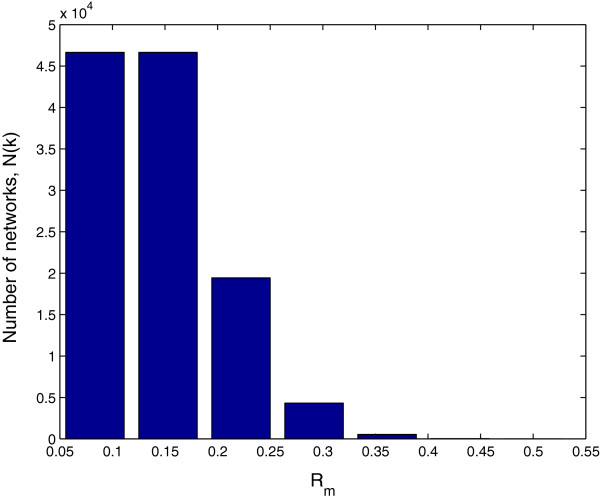
Distribution of mutational robustness for viable gene networks.n = 6; saturated equilibrium expression states (1 1 1 −1 −1 −1) and (−1 −1 −1 1 1 1).